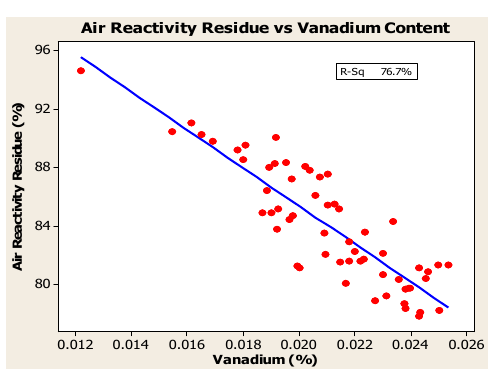
Figure 11. Air RR vs. vanadium.